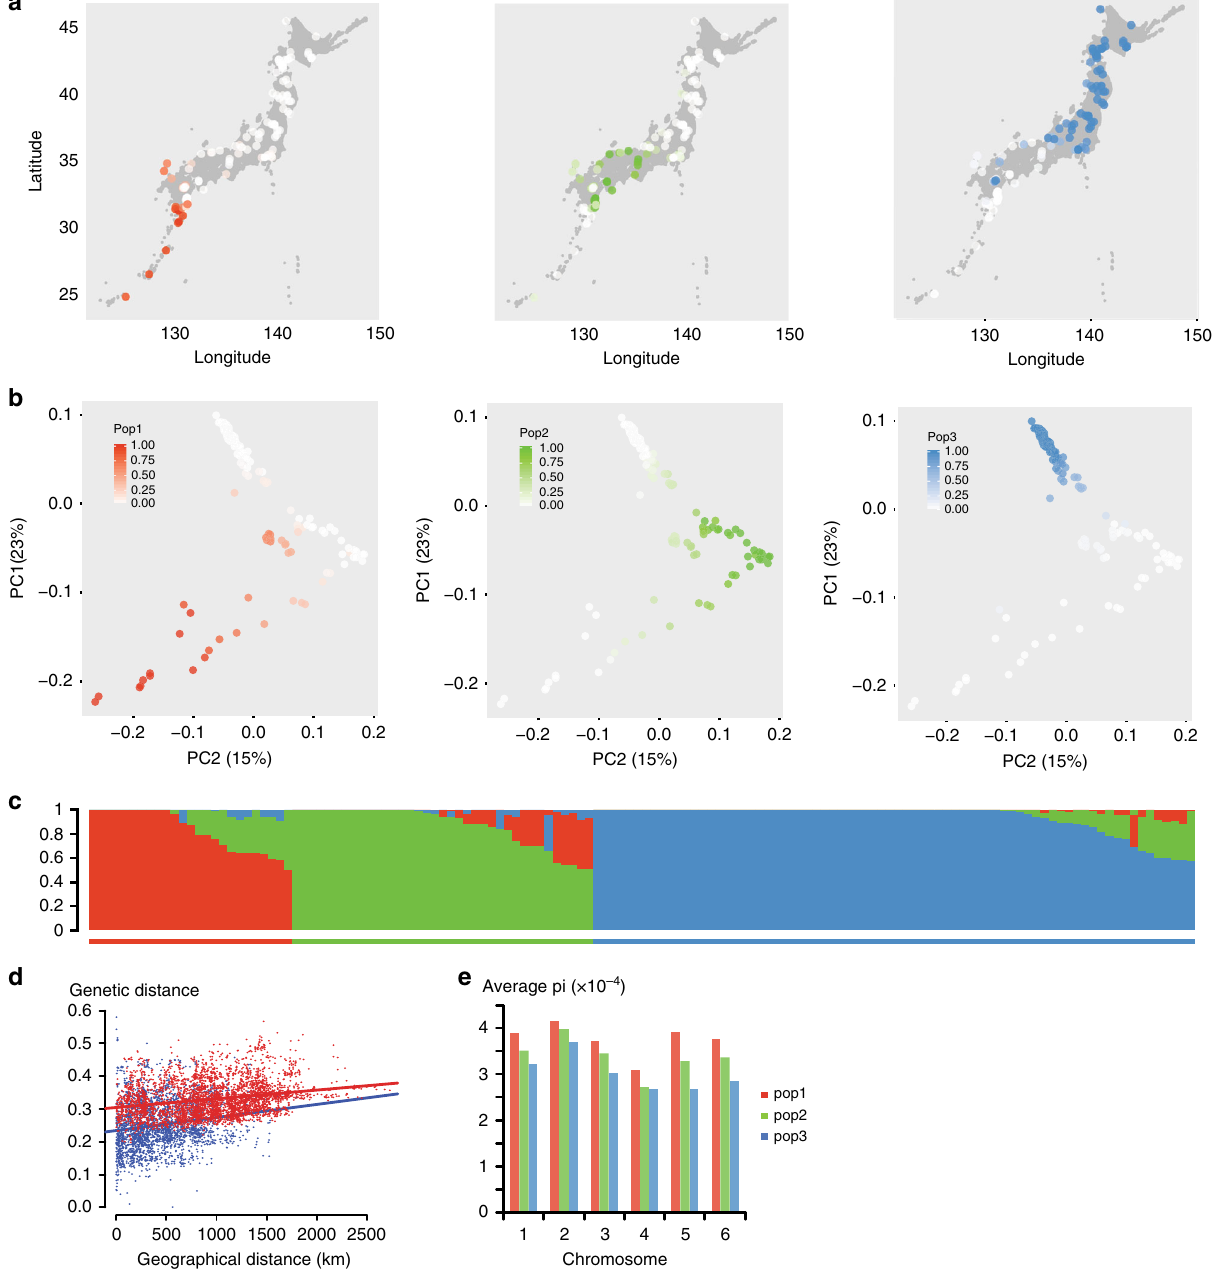
Fig. 2 Population structure and genetic diversity. a – b Accessions are colored by their population membership placed according to geographical origin ( a ) or according to their coordinates in the PCA analysis ( b ). c STRUCTURE plot showing population memberships for pop1 (red), pop2 (green) and pop3 (blue). d Genetic distance versus geographical distance. Genetic distance indicates the average number of allelic differences per polymorphic site in a pairwise comparison. Red: between-population comparisons. Blue: within population comparisons. e Average nucleotide diversity (pi) per